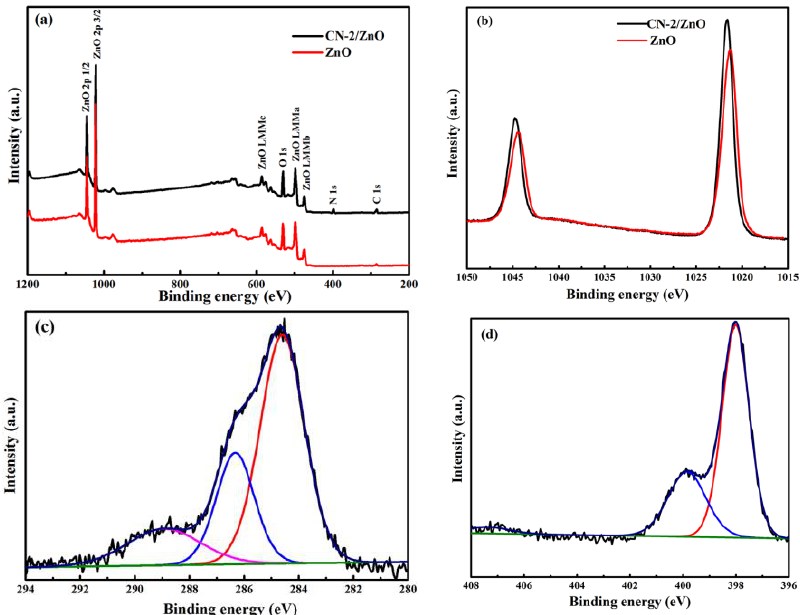
Figure 5. ( a ) X-ray photoelectron spectroscopy (XPS) survey spectra and ( b ) Zn2p peaks of CN-2/ZnO composite and ZnO; ( c ) high-resolution C1s and ( d ) N1s spectra for CN-2/ZnO composite.